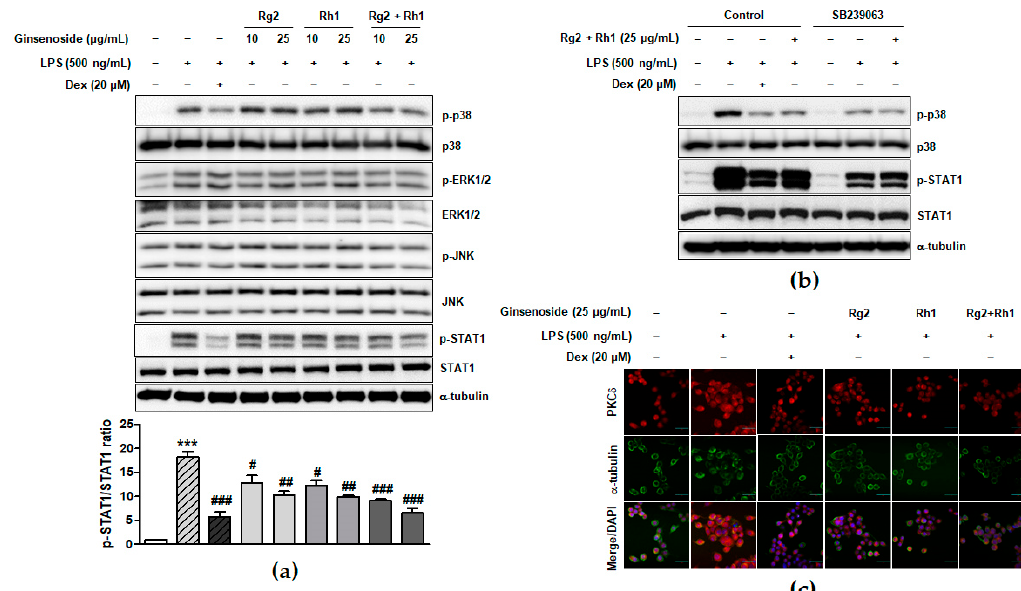
Figure 3. Inhibitory e ff ect of ginsenosides Rg2 and Rh1 on the TLR4-mediated signaling pathways in LPS-stimulated macrophages. ( a ) The cells were pre-treated with ginsenosides Rg2, Rh1, and the combination of Rg2 and Rh1 (10 and 25 µ g / mL) or dexamethasone (Dex) for 1 h followed by treatment with LPS (500 ng / mL) for 1 h. In the combination of Rg2 and Rh1, Rg2 and Rh1 were mixed with a ratio of 1:1 (10 µ g / mL of the combination contains 5 µ g / mL Rg2 and 5 µ g / mL Rh1, and so forth). ( a ; lower bar graph) The ratio of phosphorylated STAT1 / total STAT1 expression represented as the mean ± SEM ( n = 3). *** p < 0.001 compared with control sample, # p < 0.05, ## p < 0.01, and ### p < 0.001 compared with LPS-treated sample. ( b ) The cells were pre-treated with SB239063 or 25 µ g / mL of ginsenoside Rg2 and Rh1 combination (1:1 ratio) for 1 h followed by treatment with LPS (500 ng / mL) for 1 h. All phosphorylated and total proteins were analyzed by western blotting. ( c ) The RAW264.7 cells were pre-treated with ginsenosides Rg2, Rh1, the combination of Rg2 and Rh1 (1:1 ratio) (25 µ g / mL) or dexamethasone (Dex) for 3 h followed by treatment with LPS (100 ng / mL) for 1 h. Immunofluorescence analysis was performed after fixing and immunostaining with PKC δ and α -tubulin. DAPI was co-stained for visualizing nucleus. Images are shown at × 600 magnification. Scale bar indicates 30 µ